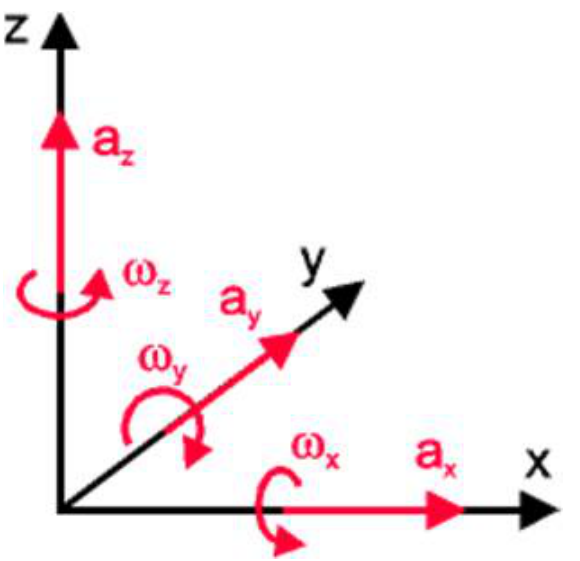
Figure 16. Basic reference system for inertial navigation.